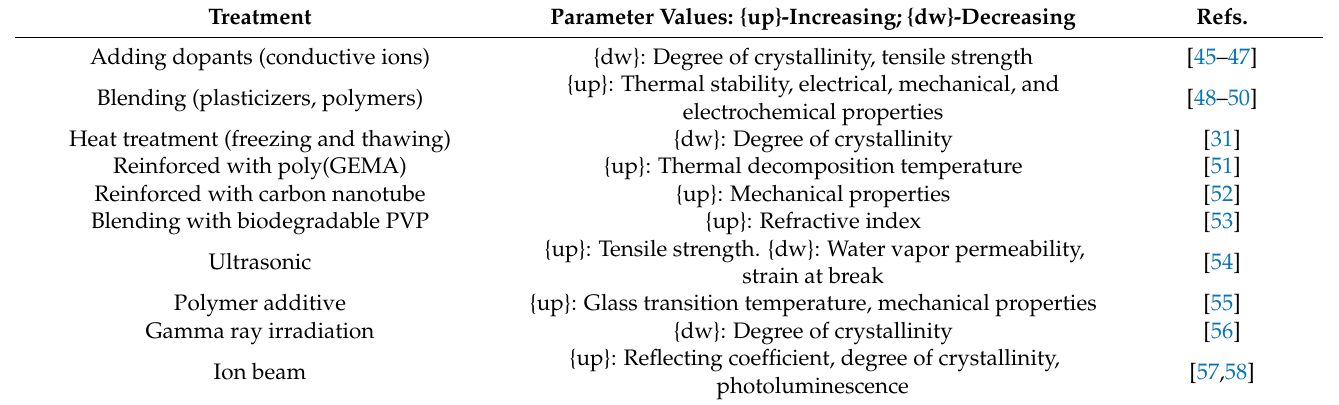
Table 1. Effects of PVA film treatments on optical and mechanical properties. Treatment Parameter Values: {up}-Increasing; {dw}-Decreasing